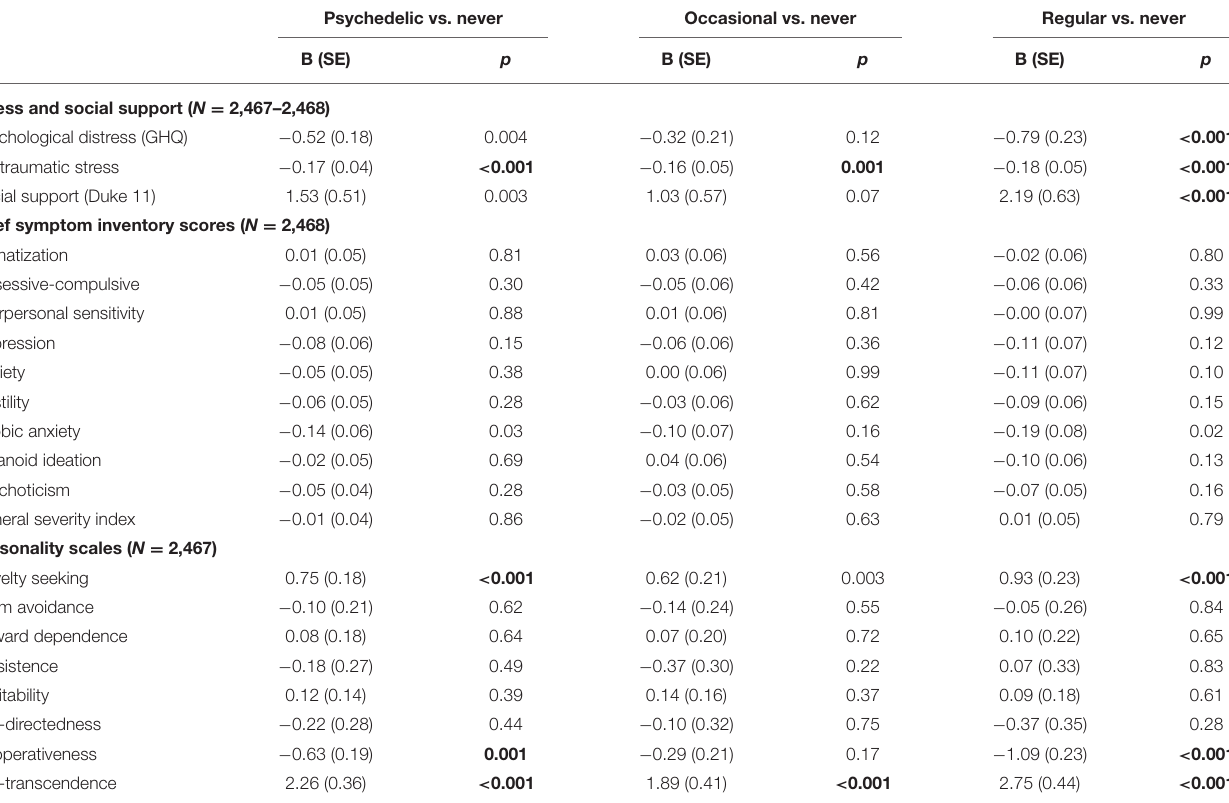
TABLE 4 | Baseline associations between lifetime psychedelic drug users vs. non-users and more specifically, regular vs. occasional vs. never users of psychedelic drugs in the past and psychometric measures. Psychedelic vs. never Occasional vs. never Regular vs.